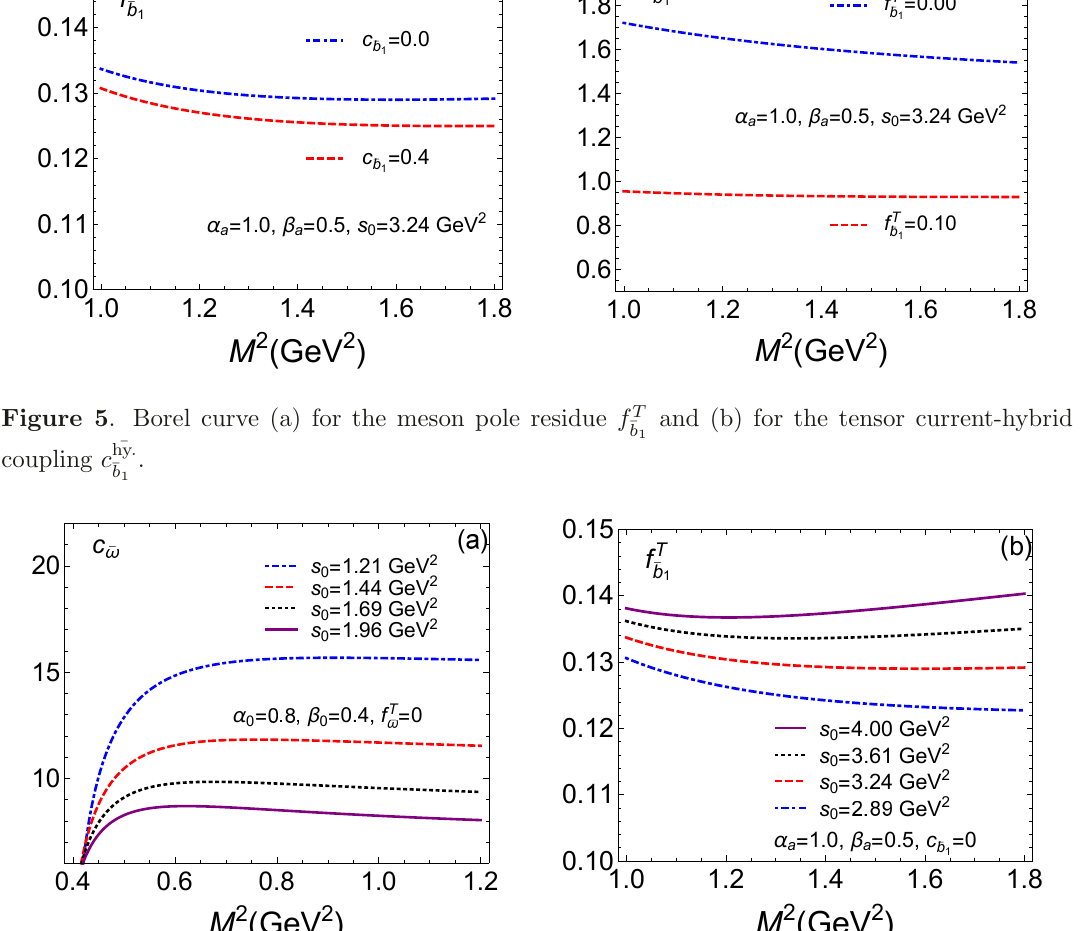
¯hy. ( f T = 0 . 00) ¯ ω ¯ ω